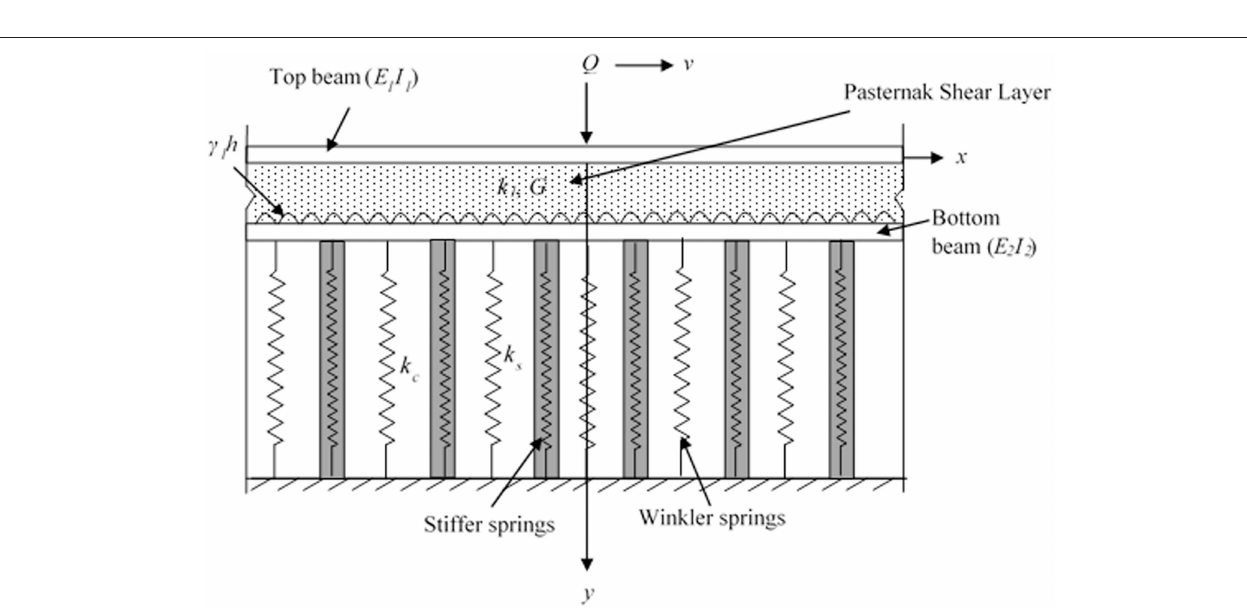
FIGURE 1 | Longitudinal section of rail resting on geocell-stone column composite reinforced earth bed.